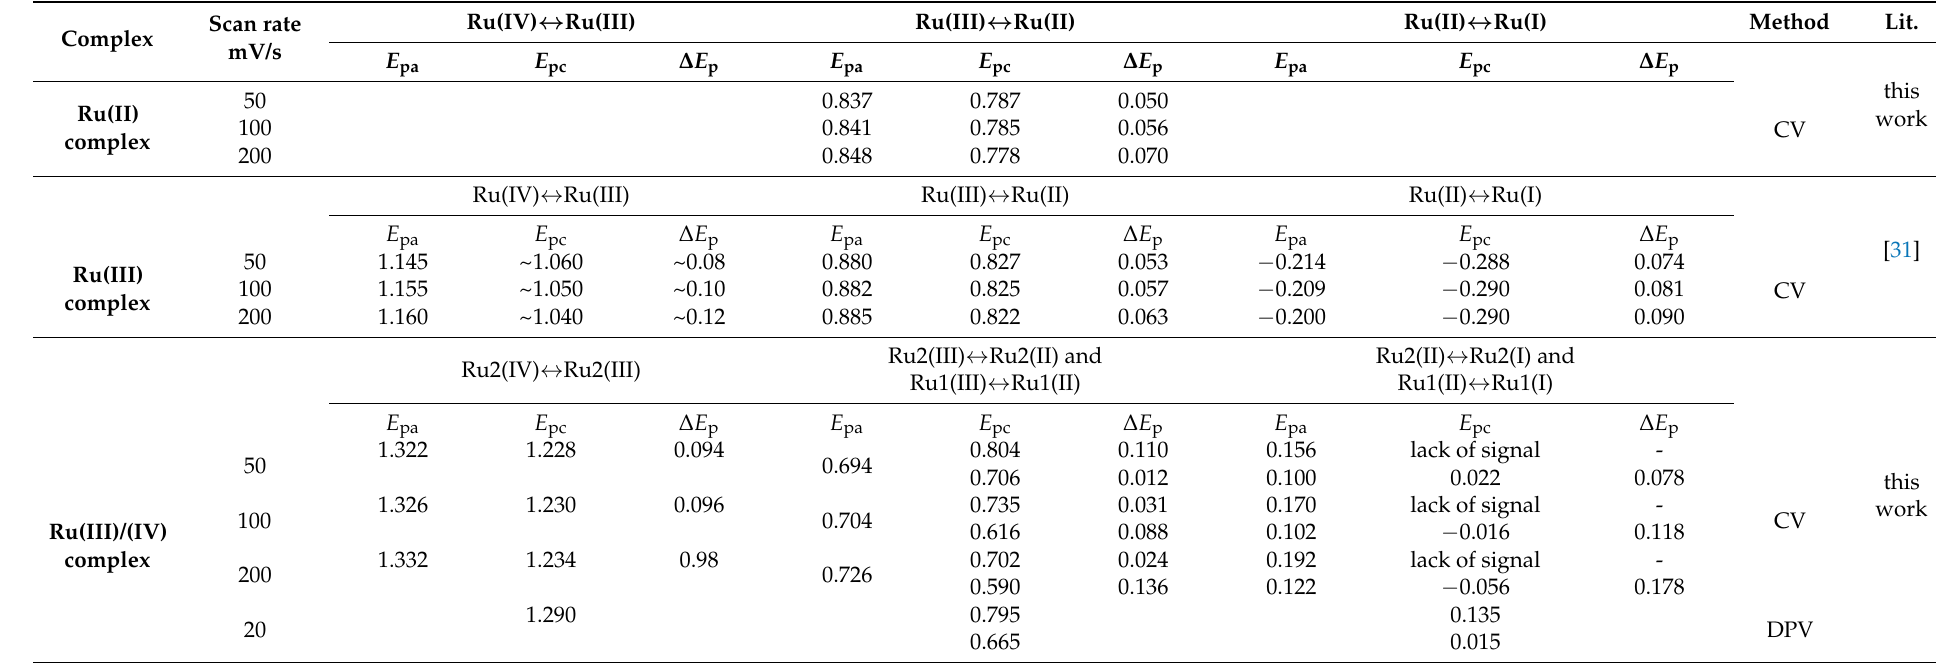
Table 1. Electrochemical data (in V vs. Ag/AgCl) for the ruthenium complexes obtained by cyclic voltammetry (CV) on GCE and by differential pulse voltammetry (DPV) on the CF disk